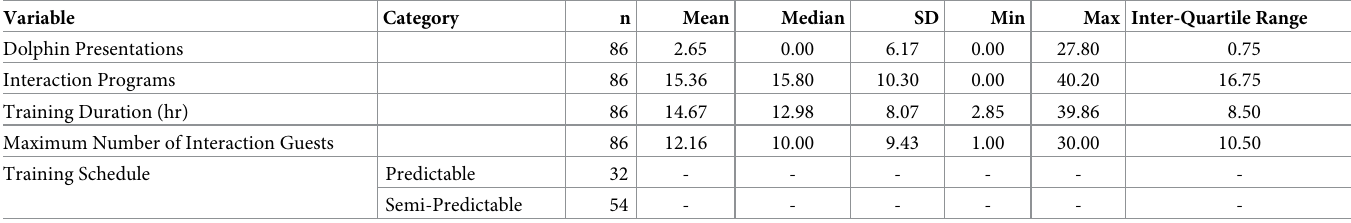
Table 4. Training